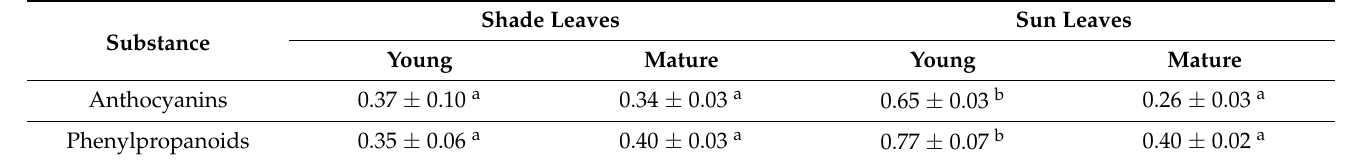
Table 3. The content of anthocyanins and phenylpropanoids in young and mature leaves of Hydrocharis morsus-ranae in the different lighting, mg/g dry weight ± SE.